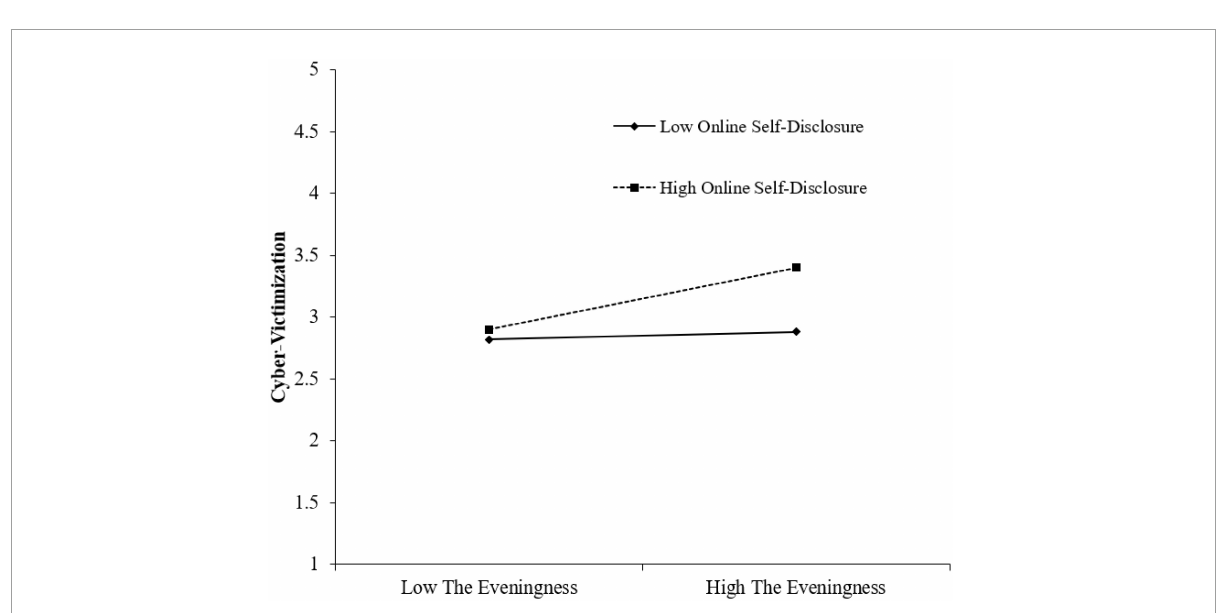
FIGURE3 Online self-disclosure as moderator on the relationship between eveningness and